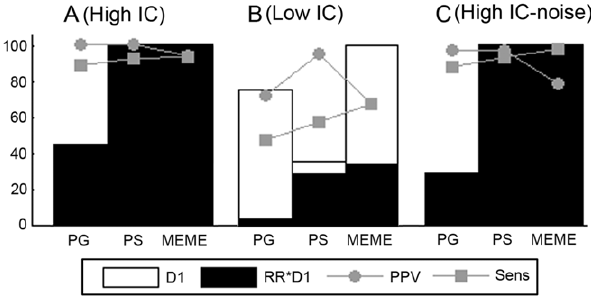
Figure 2. Results for motif detection in the coregulation space. Each dataset consists of ten coregulated genes from the reference species (proximity 0.80). Panel A displays the results for a synthetic dataset in which all sequences contain a site sampled from a high IC motif (A). Panel B shows the results for a dataset in which all sequences contain a site sampled from a low IC motif (B) and panel C shows the results of a dataset where the motif site is missing in two out of ten sequences. The remainder of the sequences contains a motif site sampled from the high IC motif. Results were assessed by the performance measures D1: the number of datasets with an output out of 100 datasets, D1*RR: the number of datasets with a correct output and the quality measures PPV (the percentage of true sites among the predicted motif sites, averaged over all correct outputs) and Sens (the percentage of the true sites recovered by the algorithm, averaged over all correct outputs).